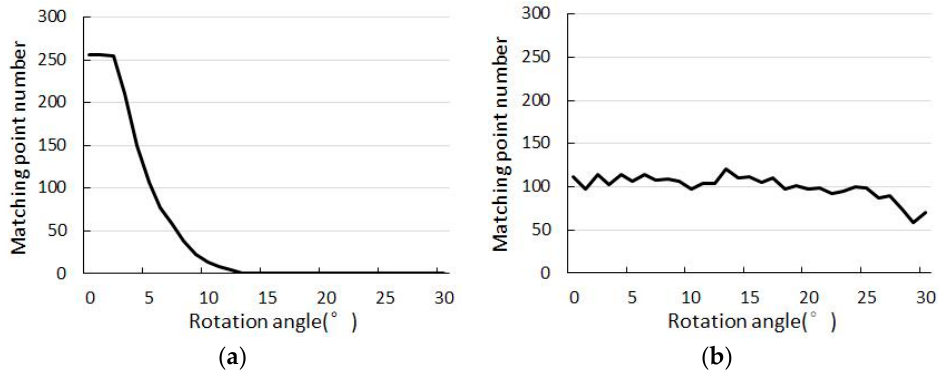
Figure 7. Number of matching points for different degrees of rotation (0–30°). ( a ) Result of the traditional NCC-based feature-tracking method; ( b ) Result of the rotation-invariant feature-tracking method.